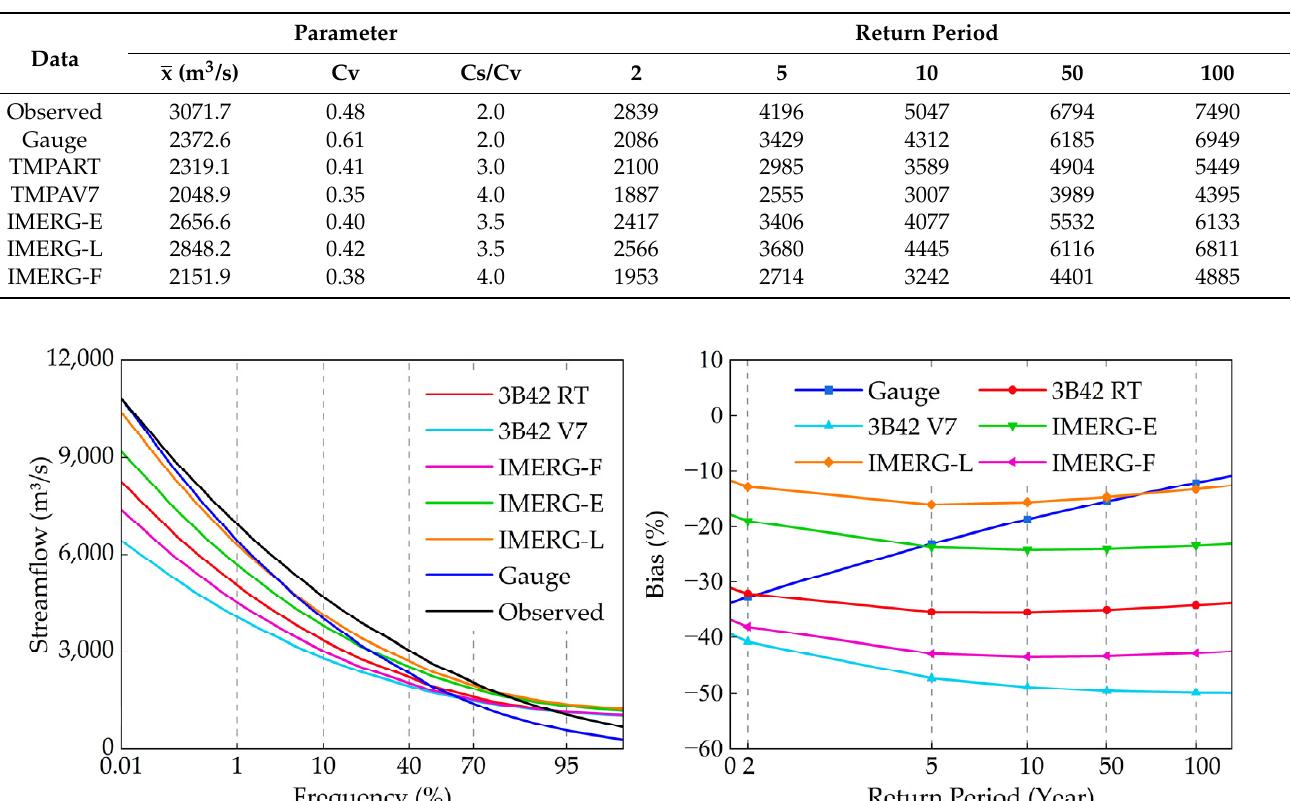
Table 4. Comparison of the statistical parameters and design floods between the observed and the five Satellite remote sensing precipitation products.